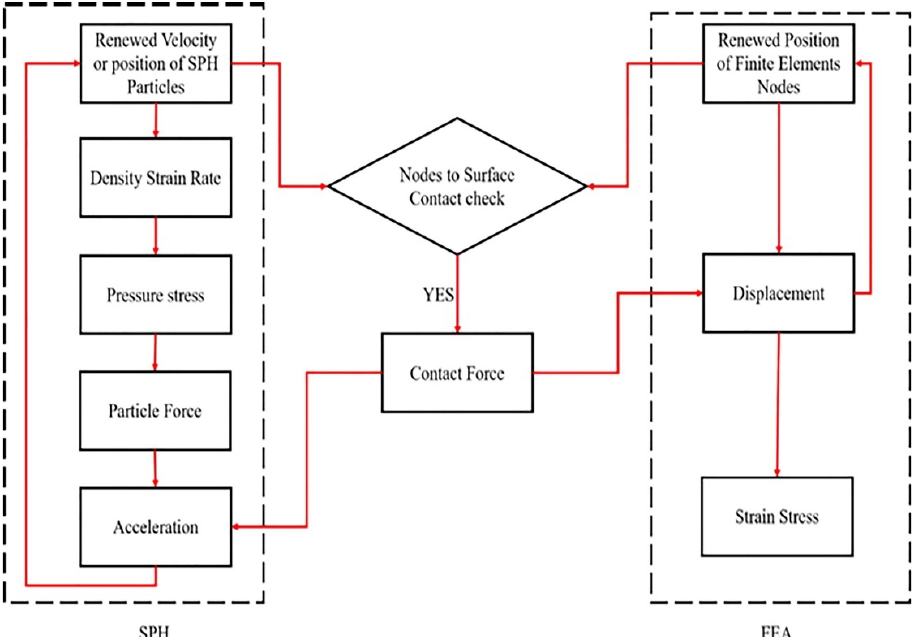
Figure 24. General process of coupling SPH with FEA [164].